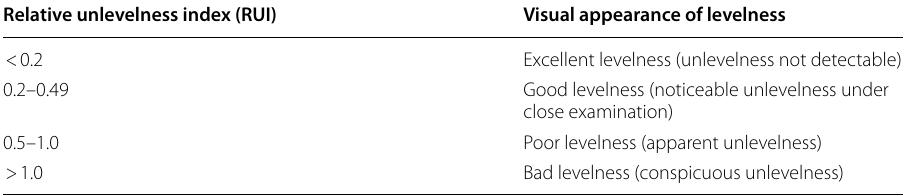
Table 1 Suggested interpretation of RUI values Relative unlevelness index (RUI) Visual appearance of levelness <